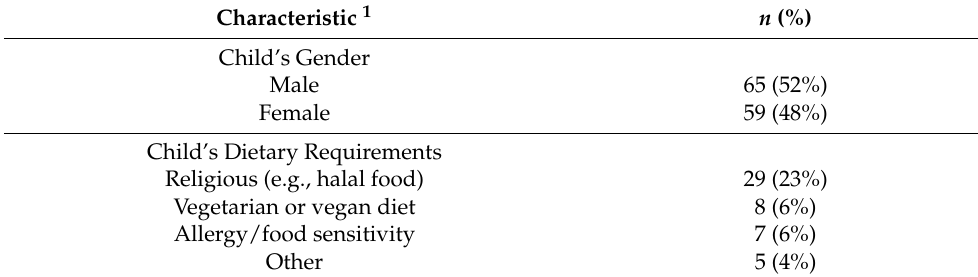
Table 2. Cont. Characteristic 1 n (%) Child’s Gender